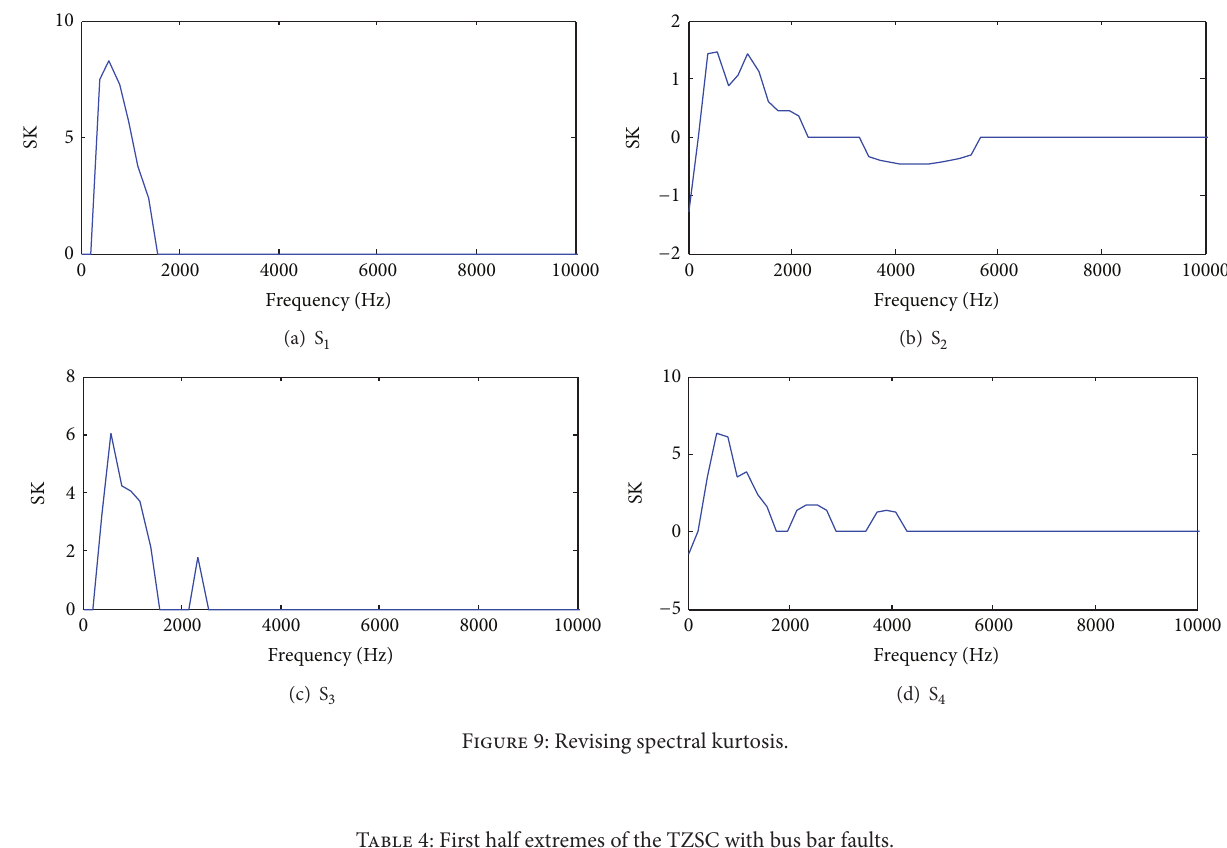
Table 4: First half extremes of the TZSC with bus bar faults.